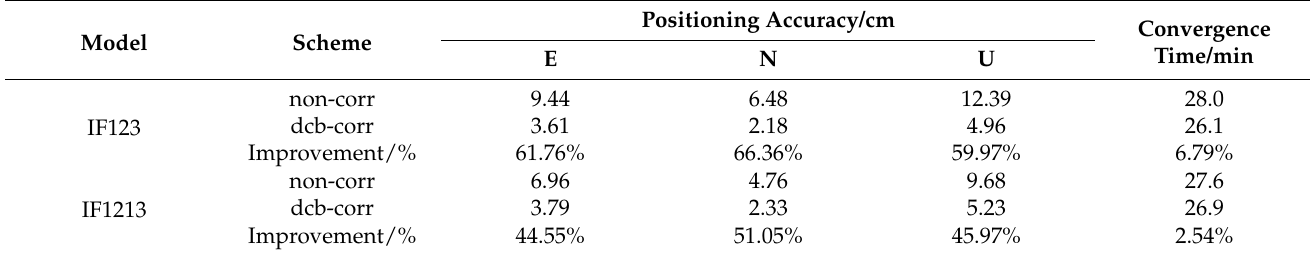
Table 5. Average positioning accuracy of PPP for IF123 and IF1213 models.